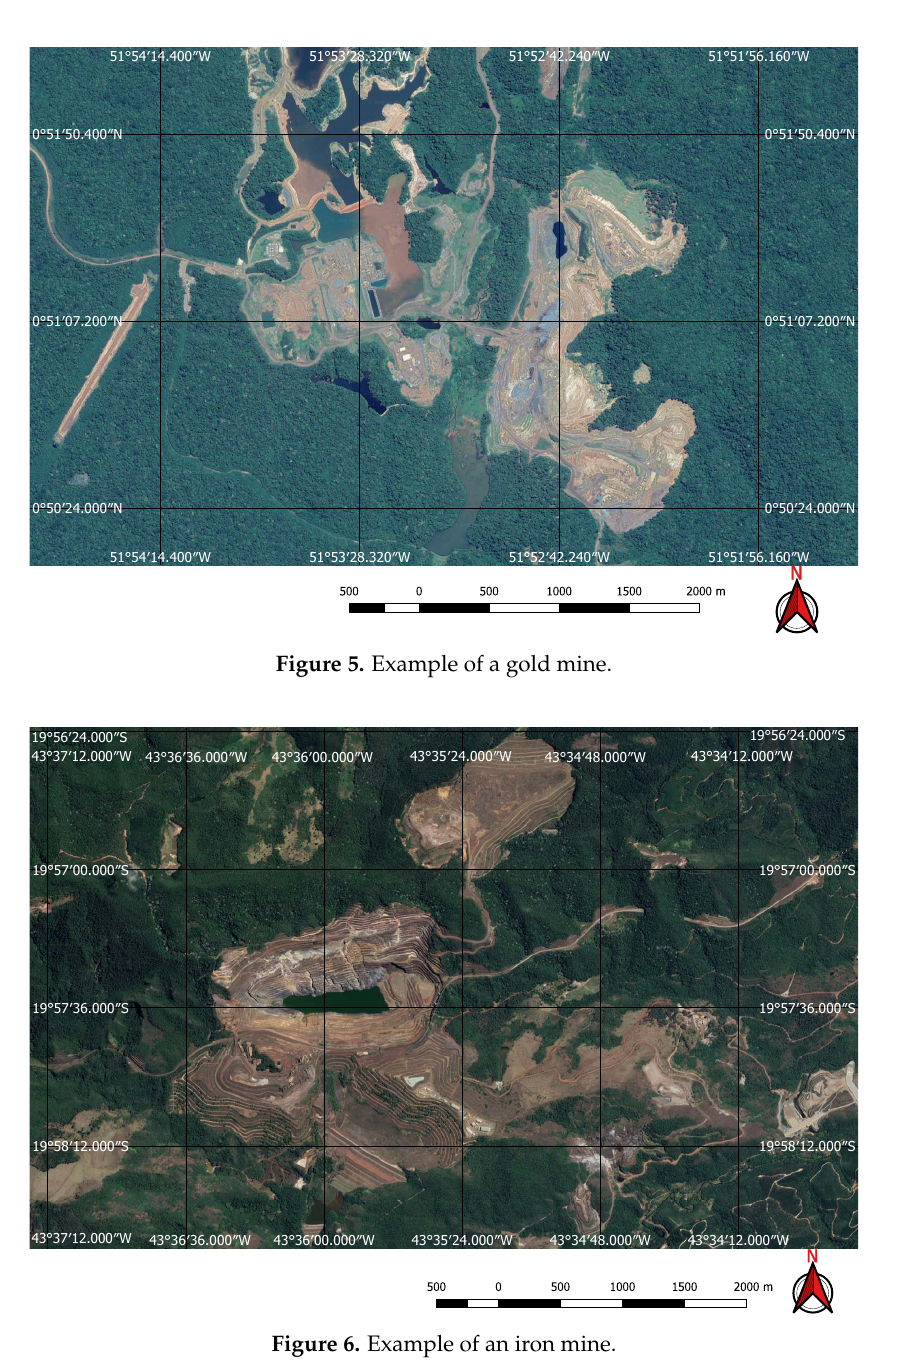
Figure 6. Example of an iron